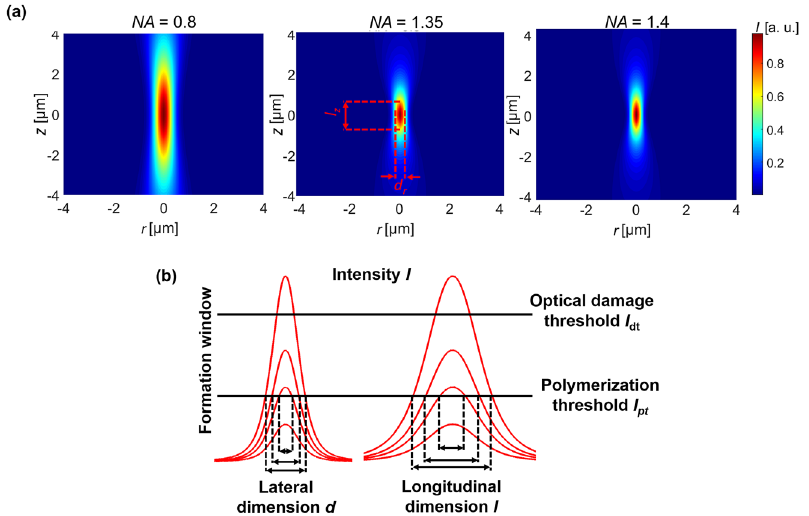
Figure 5: Spatial confinement of light in